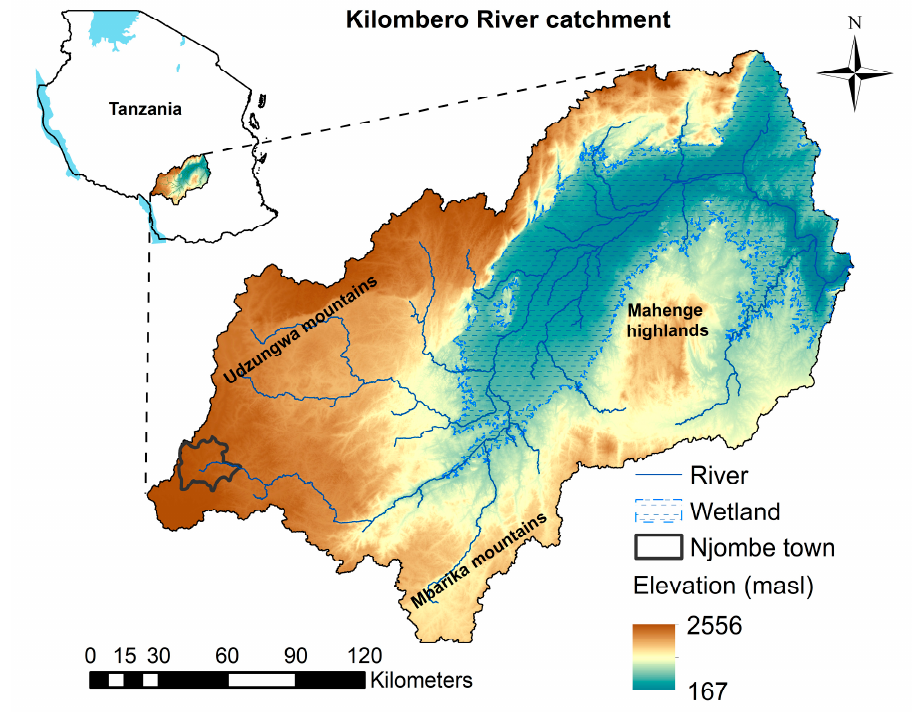
Figure 1. Kilombero River catchment (elevation: [35]).